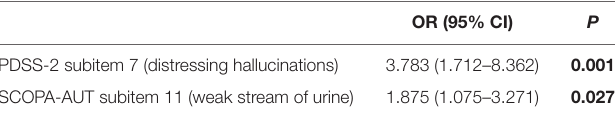
TABLE 4 | Correlation analysis between RBDSQ-J total scores and clinical variables.